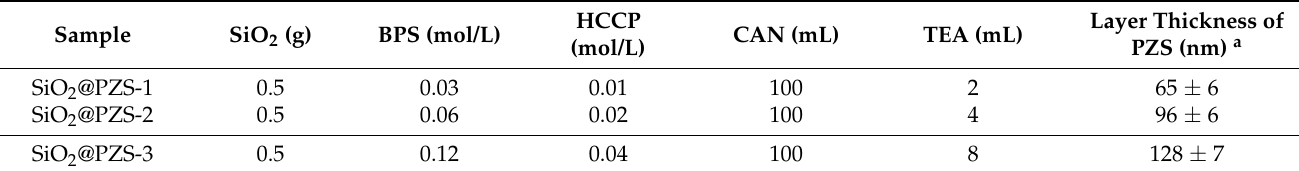
Table 1. Synthesis of silica-polyphosphazene nanoparticles (SiO 2 @PZS).